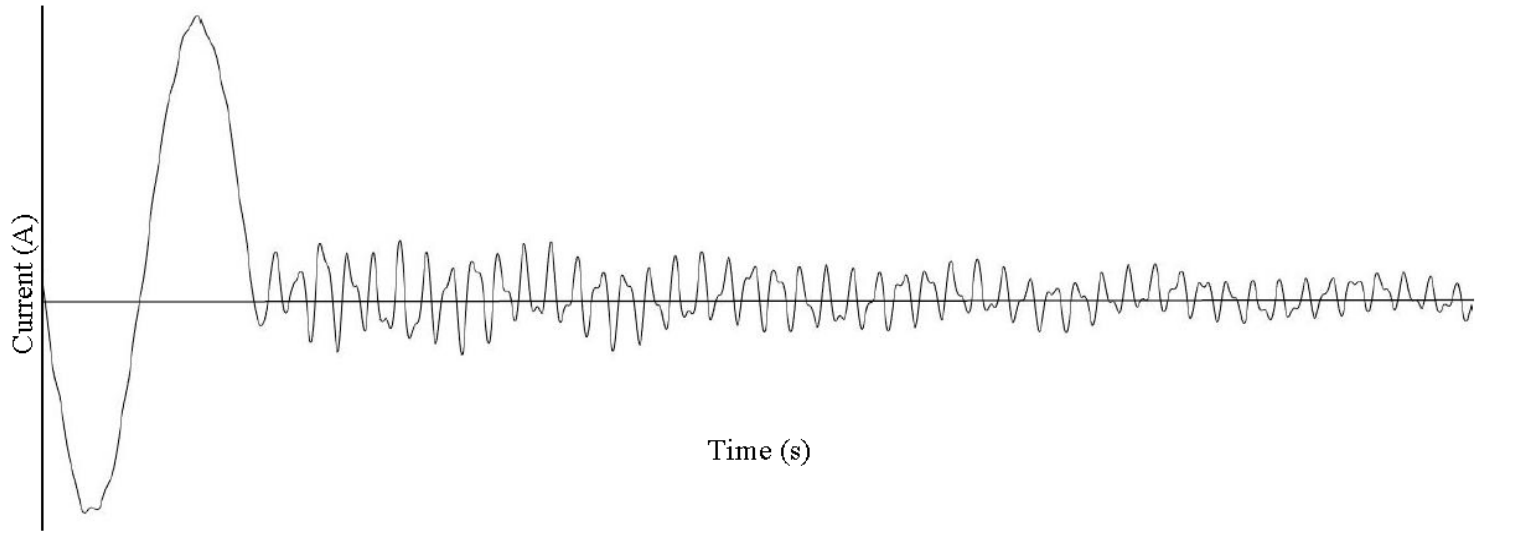
Figure 16. Bus capacitance increased by 40%.